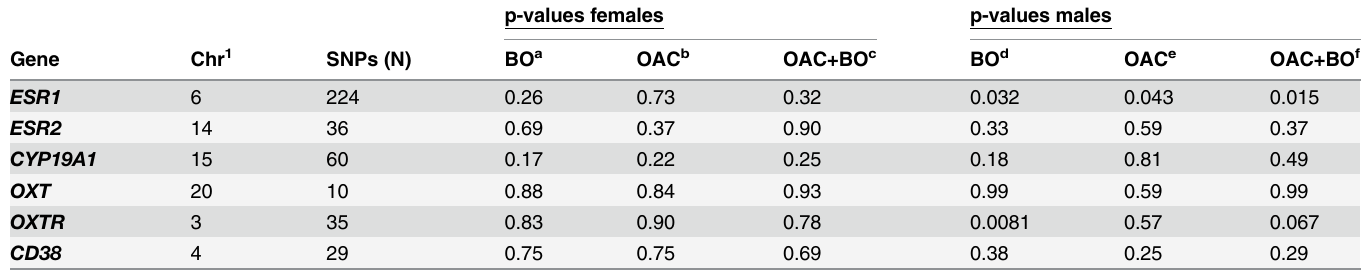
Table 3. Sex-specific gene-based analysis for genes known to regulate oestrogen levels and oxytocin levels and risk of Barrett ’ s oesophagus (BO), oesophageal adenocarcinoma (OAC), and these conditions combined (OAC+BO). P-values in bold are statistically significant.